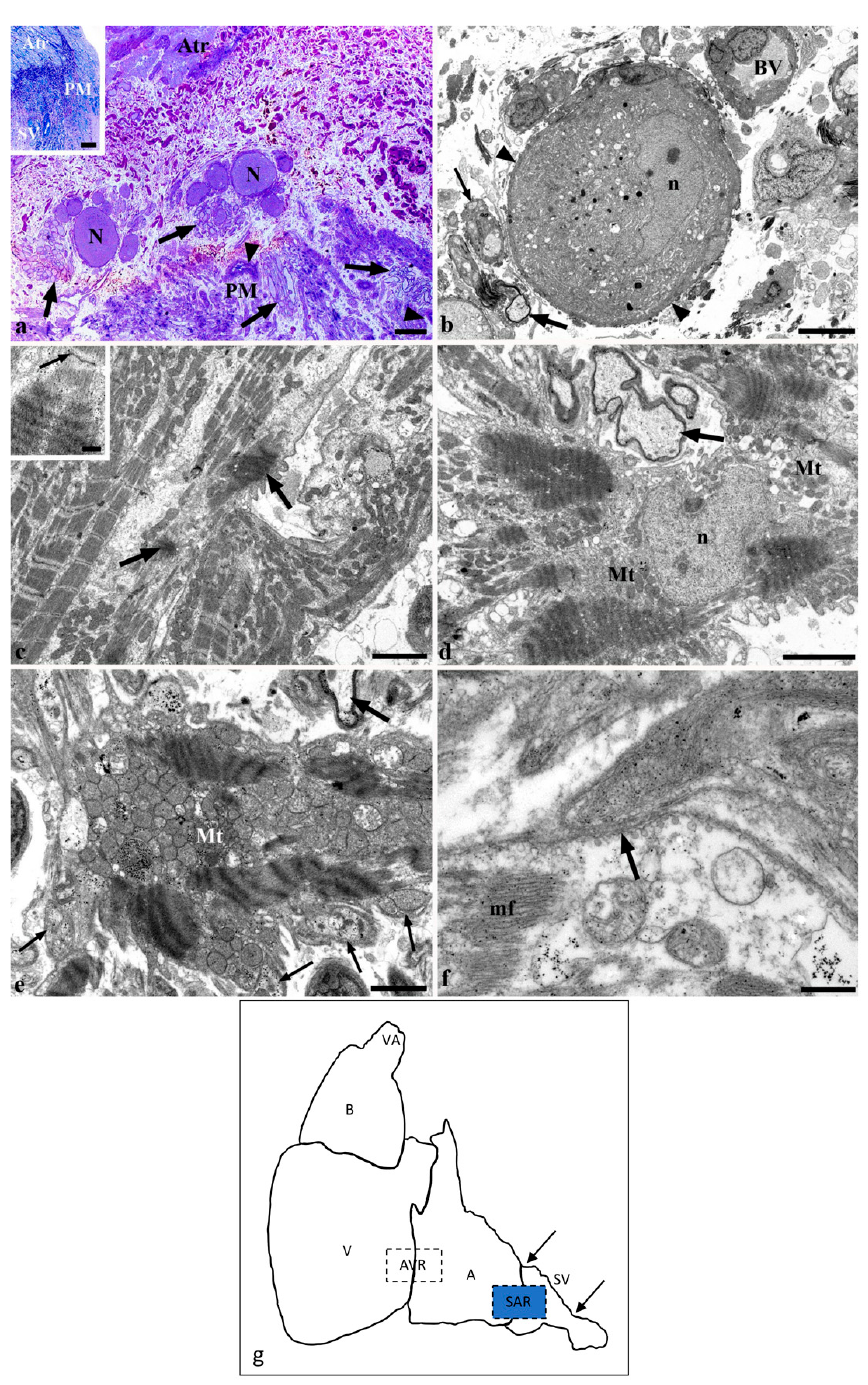
Figure 1. Histology and structure of the sinoatrial region and pacemaker area. ( a ) Semithin section. Sinus venosus wall. Large neuronal bodies (N) locate between the atrial myocardium (Atr) and the pacemaker (PM) area. The pacemaker tissue contains loosely organized myocardial bundles, small blood vessels (arrowheads) and abundant nerve bundles (arrows). Other nerve bundles locate close to the neuronal bodies. Inset of a: semithin section. Low magnification of the sinoatrial region. The atrium (Atr) and sinus venosus (SV) are separated by connective tissue. The pacemaker area (PM) is indicated. ( b ) TEM. A neuronal body showing nucleus (n) and nucleolus, lysosomal bodies and supporting glia (arrowheads) is surrounded by blood vessels (BV) and myelinated (thick arrow) and unmyelinated (thin arrow) nerve fibers. ( c ) TEM. The cytoplasm of the central myocyte shows two small areas of myofibrillar condensation (arrows). The surrounding cells